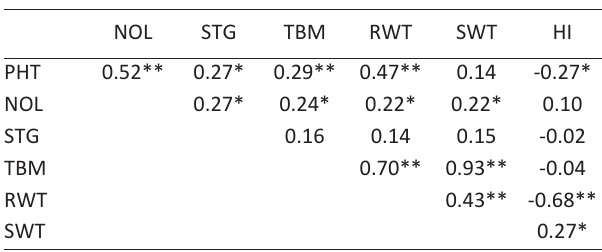
Table 4 ­ Pearson correlation coefficients among measured traits of 21 Amaranthus accessions evaluated in 2018 and 2019